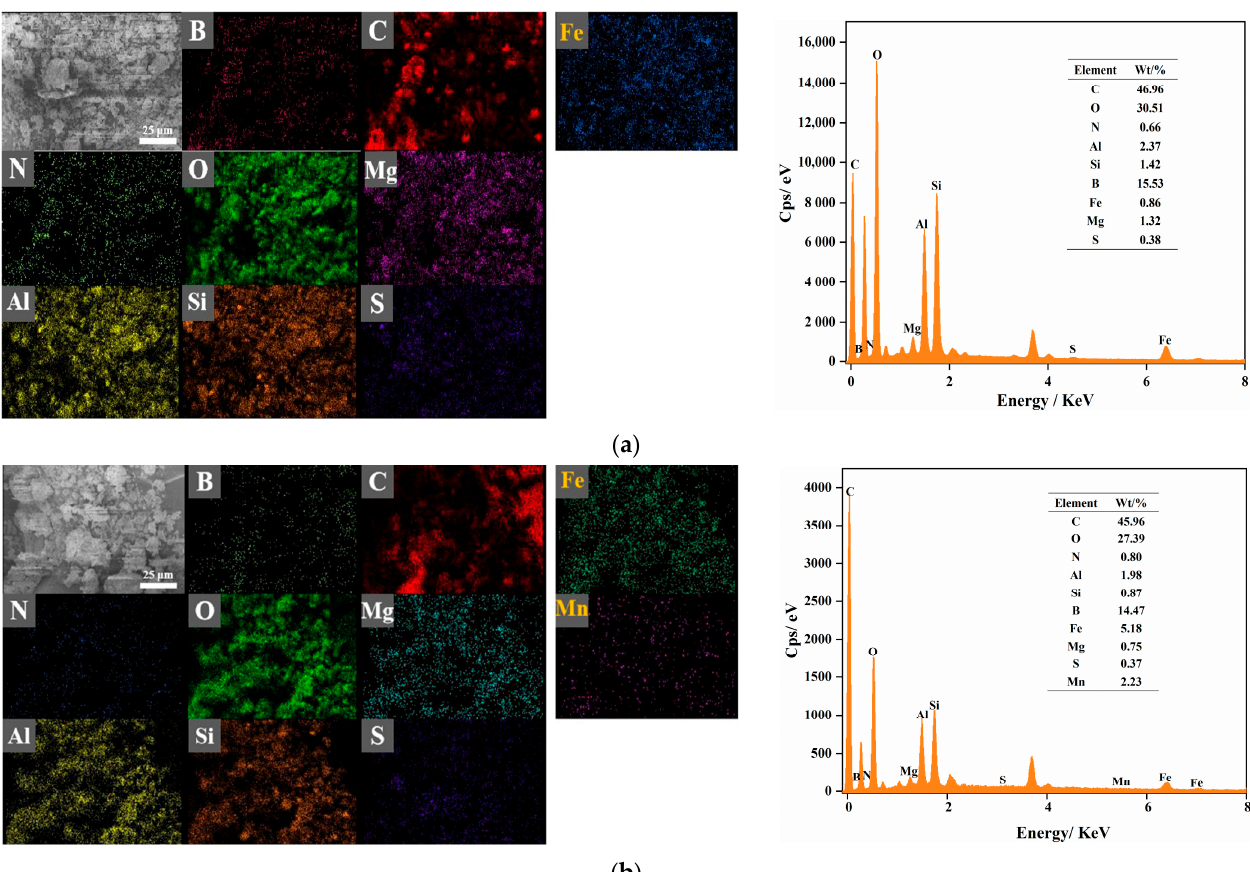
Figure 11. EDS surface scan images of IHA/TM composite particles before ( a ) and after ( b ) adsorption of Fe 2+ and Mn 2+ .